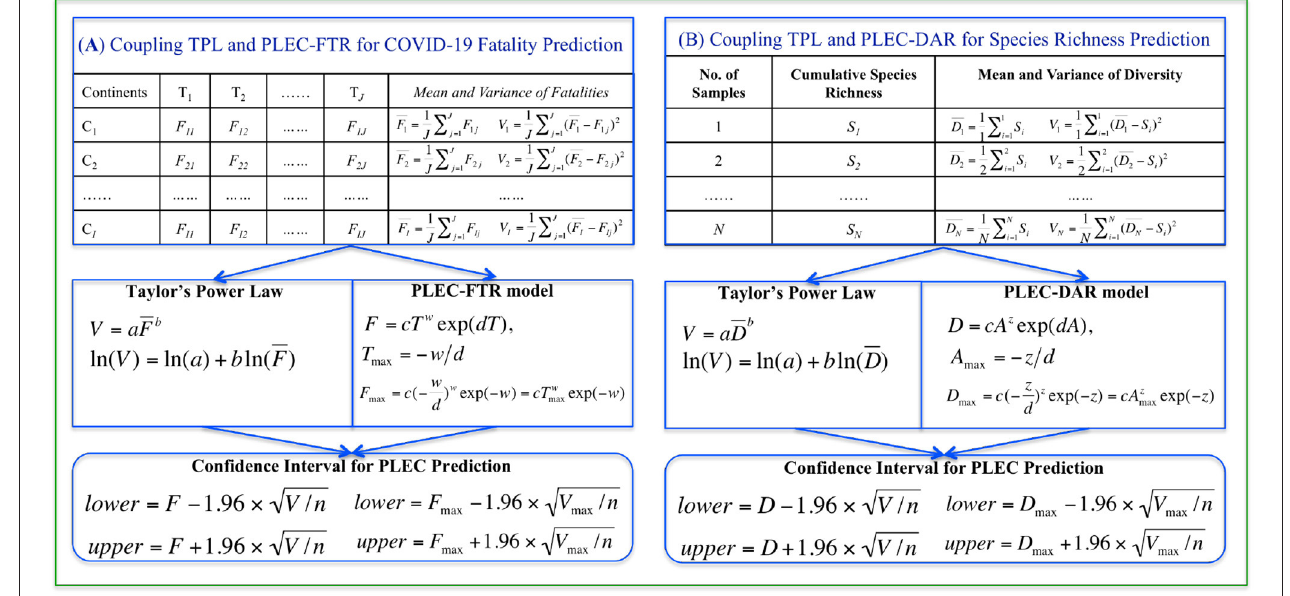
FIGURE 1 | A diagram illustrating the coupling of TPL and PLEC models: for predicting COVID-19 fatality [ (A) the left block] and American gut microbiome diversity [ (B) the right block]. The top pair of boxes in both case studies illustrates the format of input data, the middle boxes specify the power law models, and the bottom boxes list the formulae for computing the